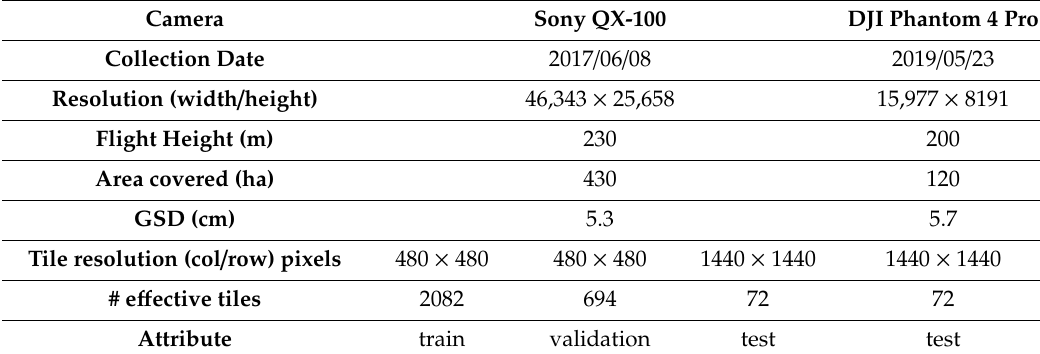
Table 2. Details of data collection.